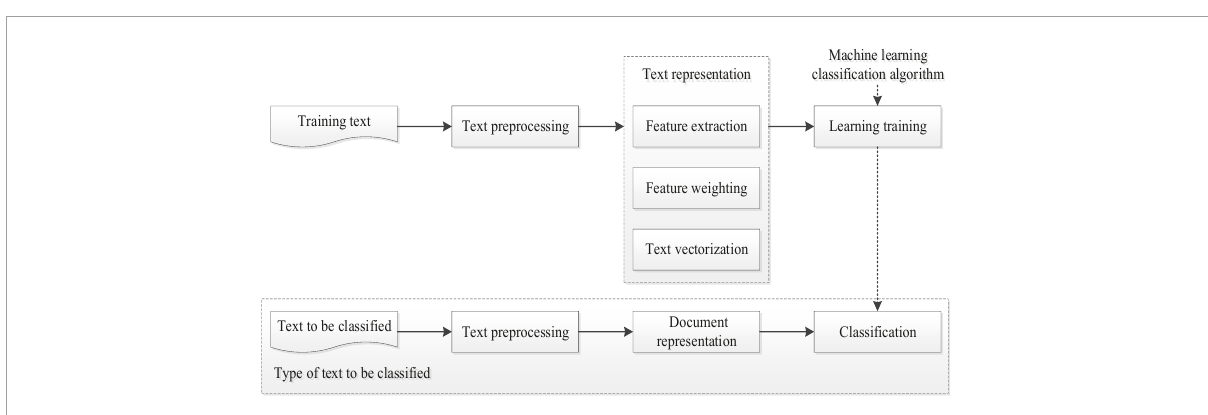
FIGURE4 Emotional polarity analysis process based on machine learning.